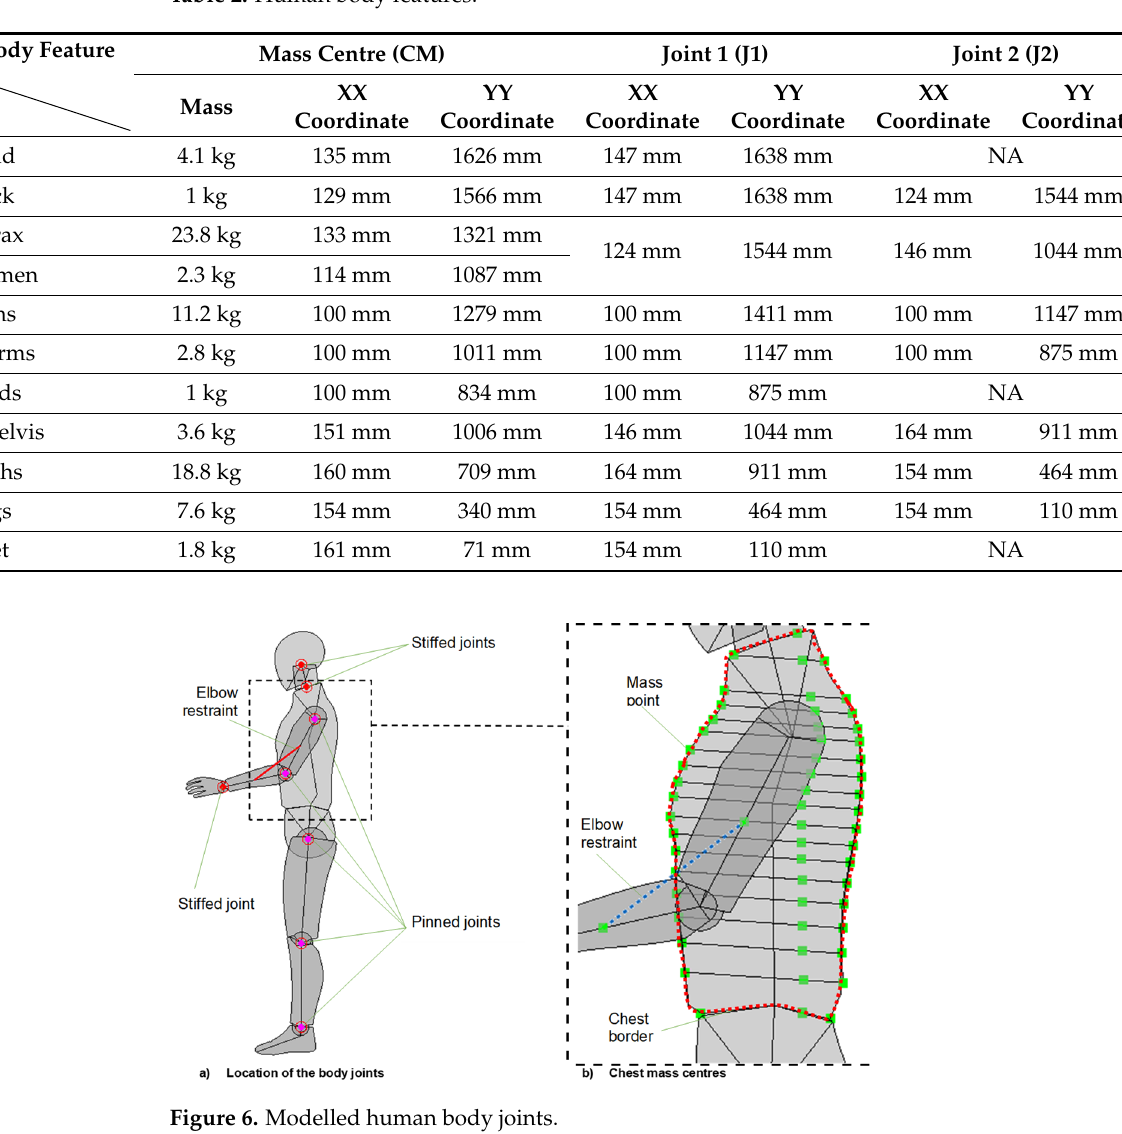
Table 2. Human body features.